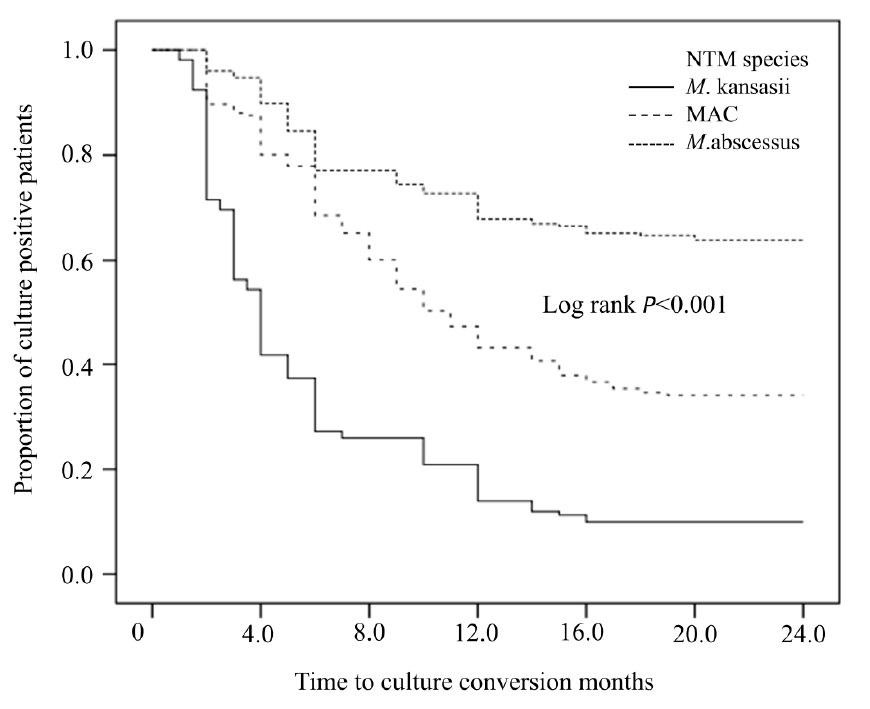
Figure 4. Sputum culture conversion rates of patients infected by M. Kansasii , MAC, and M. abscessus . NTM: nontuberculous mycobacteria, and MAC: Mycobacterium avium complex.